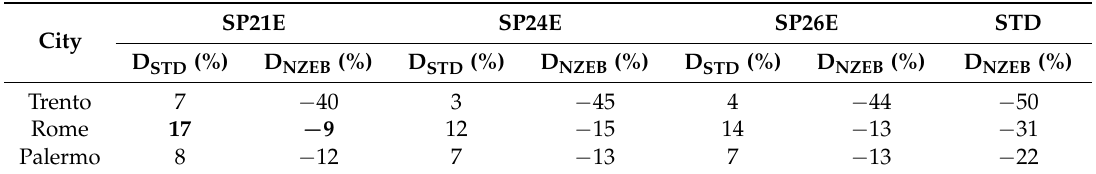
Table 8. Percentage difference of annual delivered energy of the buildings with the three PCM with respect to STD and NZEB reference buildings. Numbers in bold highlight the best percentage of energy saving.